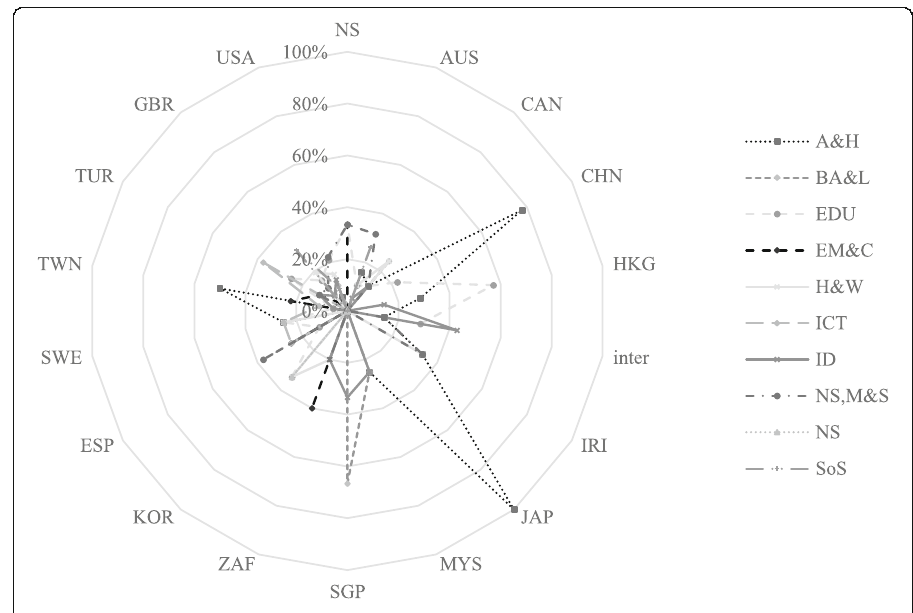
Fig. 4 Relative frequencies of study field in dependence of countries with ≥ 3 articles. Note. Country abbreviations are as per Figure 4. A&H = Arts & Humanities; BA&L = Business, Administration and Law; EDU = Education; EM&C = Engineering, Manufacturing & Construction; H&W = Health & Welfare; ICT